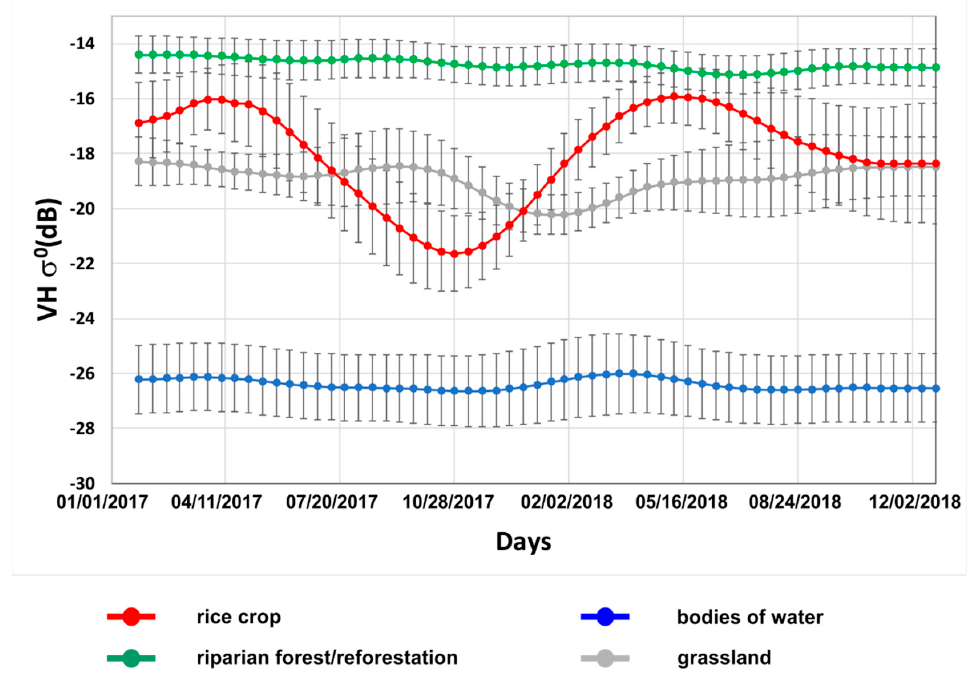
Figure 8. Behavior of the mean time series with the respective standard deviation bars for the main targets (rice planting, bodies of water, riparian forest, and grassland) present in the region of Uruguaina, southern Brazil.